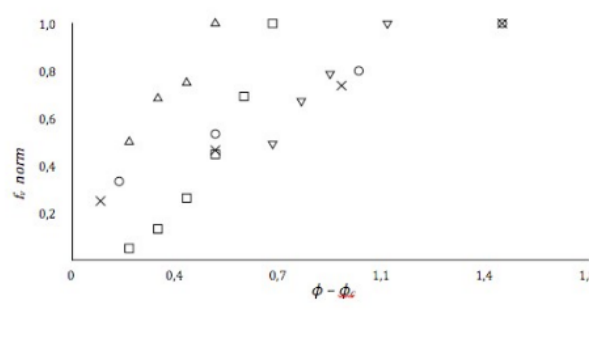
Figure 4: Normalized f ν values in function of the equivalence ratio ( ϕ − ϕ ) for the present study (x), in comparison to the results of c [12], ( (cid:52) ), [17] ( (cid:3) ), [19] ( (cid:79) ) and [18] (o).